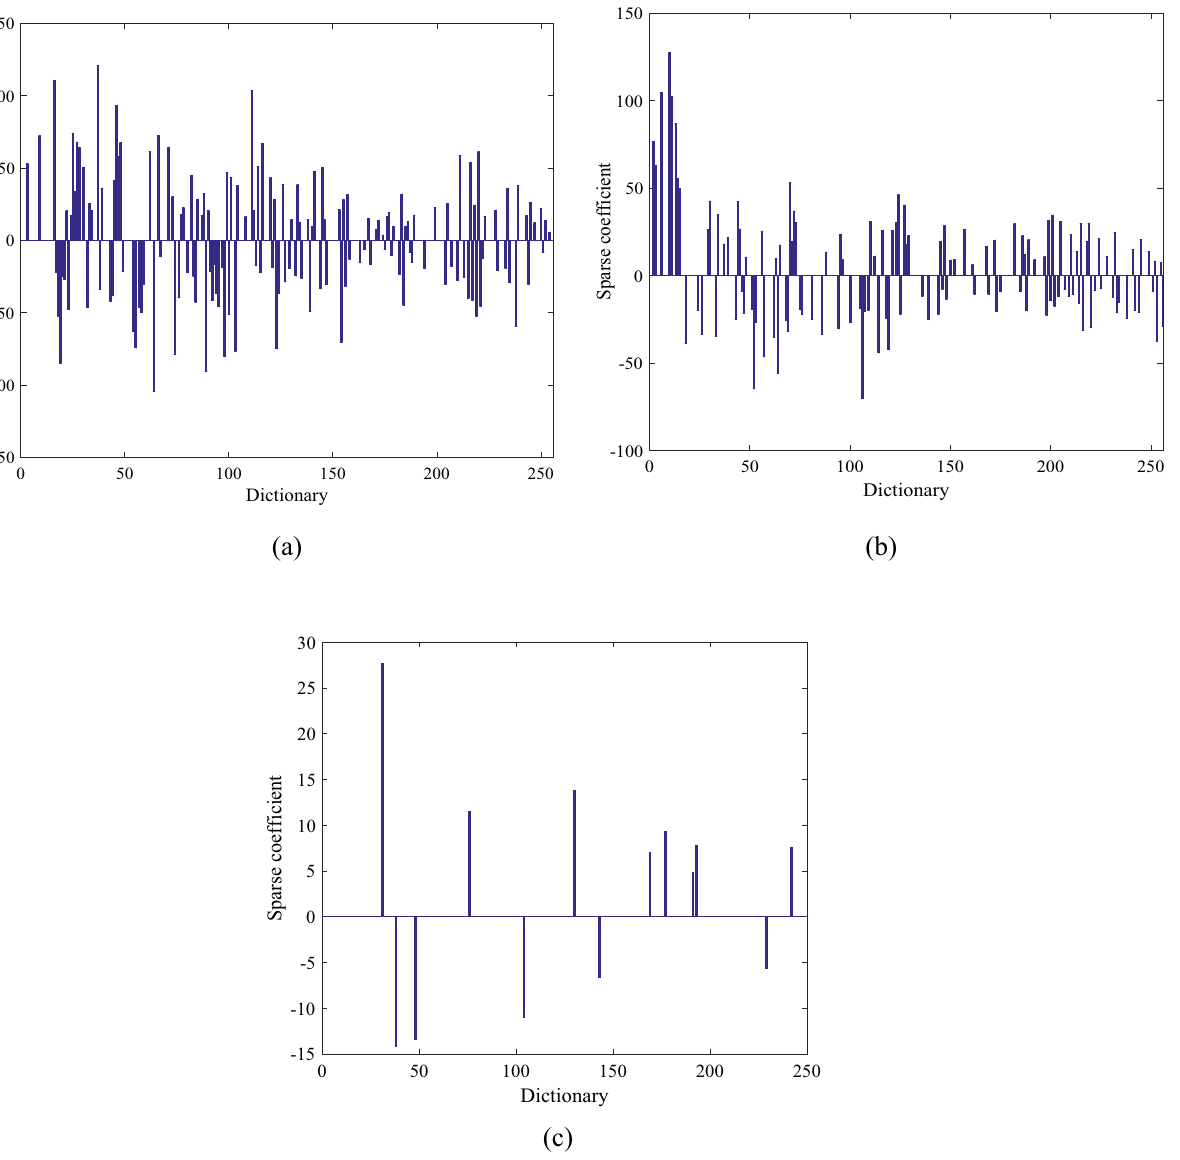
Figure 7. Sparse representation coefficient of settlement in subgrade defects dictionary. ( a ) Sparse coefficient of settlement in dictionaryA 2 , ( b ) Sparse coefficient of settlement in dictionaryA 3 , ( c ) Sparse coefficient of settlement in dictionaryA 1